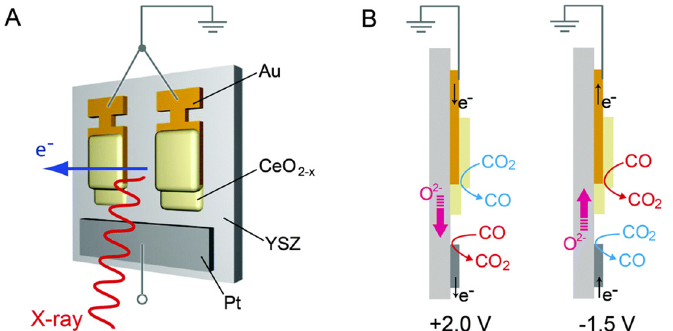
Figure 8. ( A ) Schematic setup of an electrochemical cell comprising a 300 nm Pt counter electrode (CE), a 300 nm Au current collector on top of a 50 nm alumina film (not shown) and a 350 or 1000 nm ceria working electrode (WE) patterned onto a polycrystalline yttria-stabilized zirconia (YSZ) substrate. ( B ) Schematic illustration of electrochemical reactions under positive and negative biases. Reprinted with permission from [303], copyright 2014, Royal Society of Chemistry.